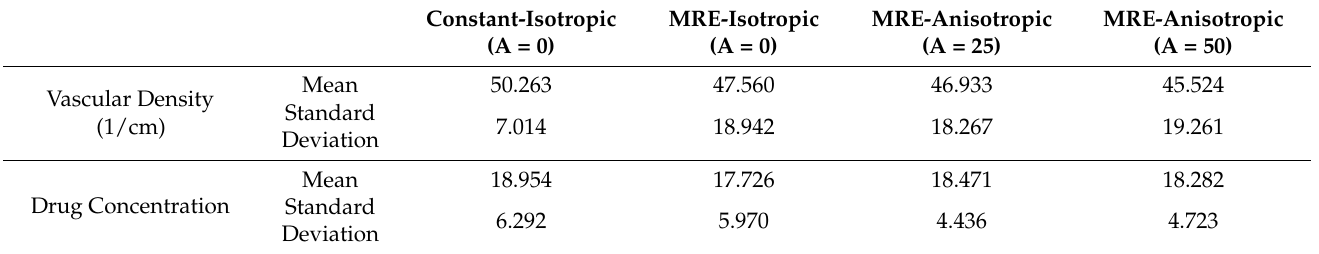
Table 1. Mean and standard deviation values of the spatial distribution of the vascular density and drug concentration in the tumor for the 4 cases considered in Figure 3.